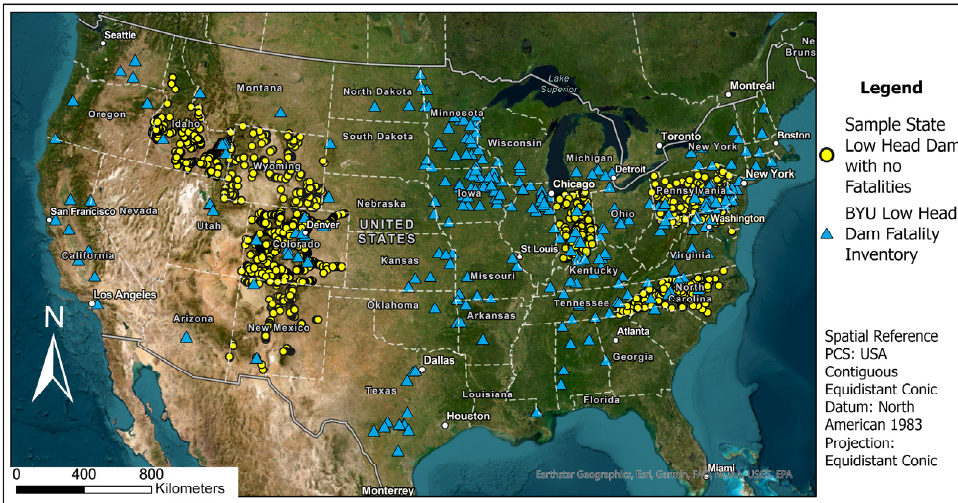
Figure 3. Map of all of the low head dam locations used in the study.